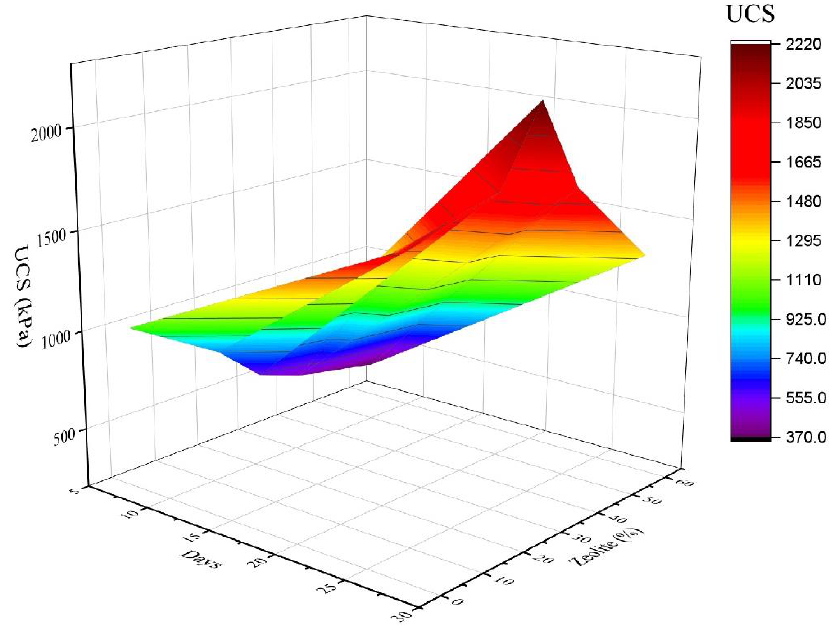
Figure 12. Continuous three-dimensional procedure of UCS values versus percentage of replaced zeolite and treatment times for laboratory results and values estimated from the model.